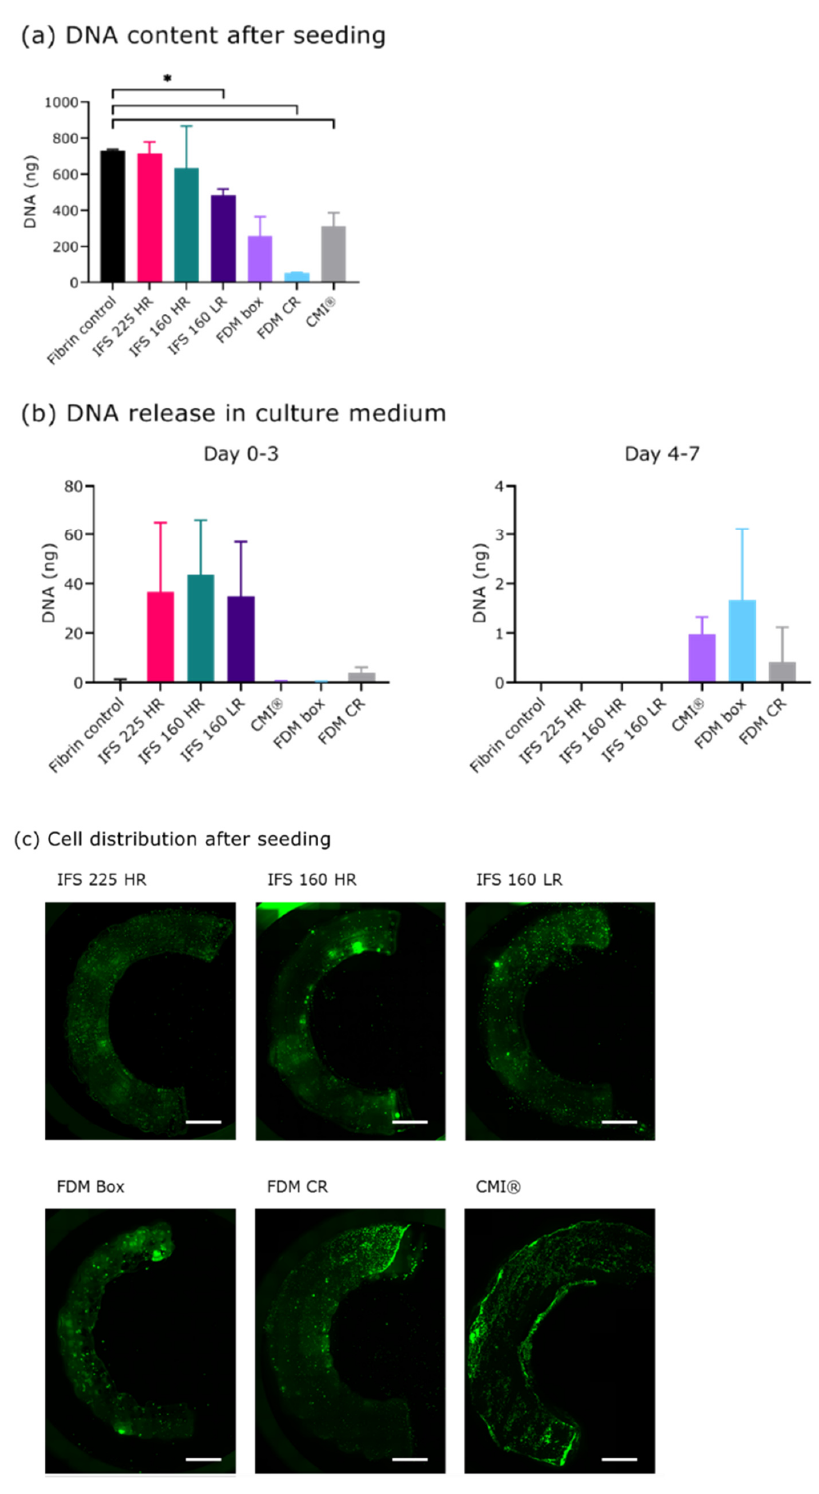
Figure 2. Cell seeding and DNA release into the culture medium. ( a ) DNA content of seeded scaffolds and fibrin gel controls. ( b ) DNA release in culture medium as indirect measure of cell retention in the scaffold in the first week after seeding ( n = 3 technical replicates, 1 donor). ( c ) Cell distribution 1 day after seeding, green fluorescent dye is Calcein AM. *, p < 0.05. Abbreviations; 160: 160 µm, 225: 225